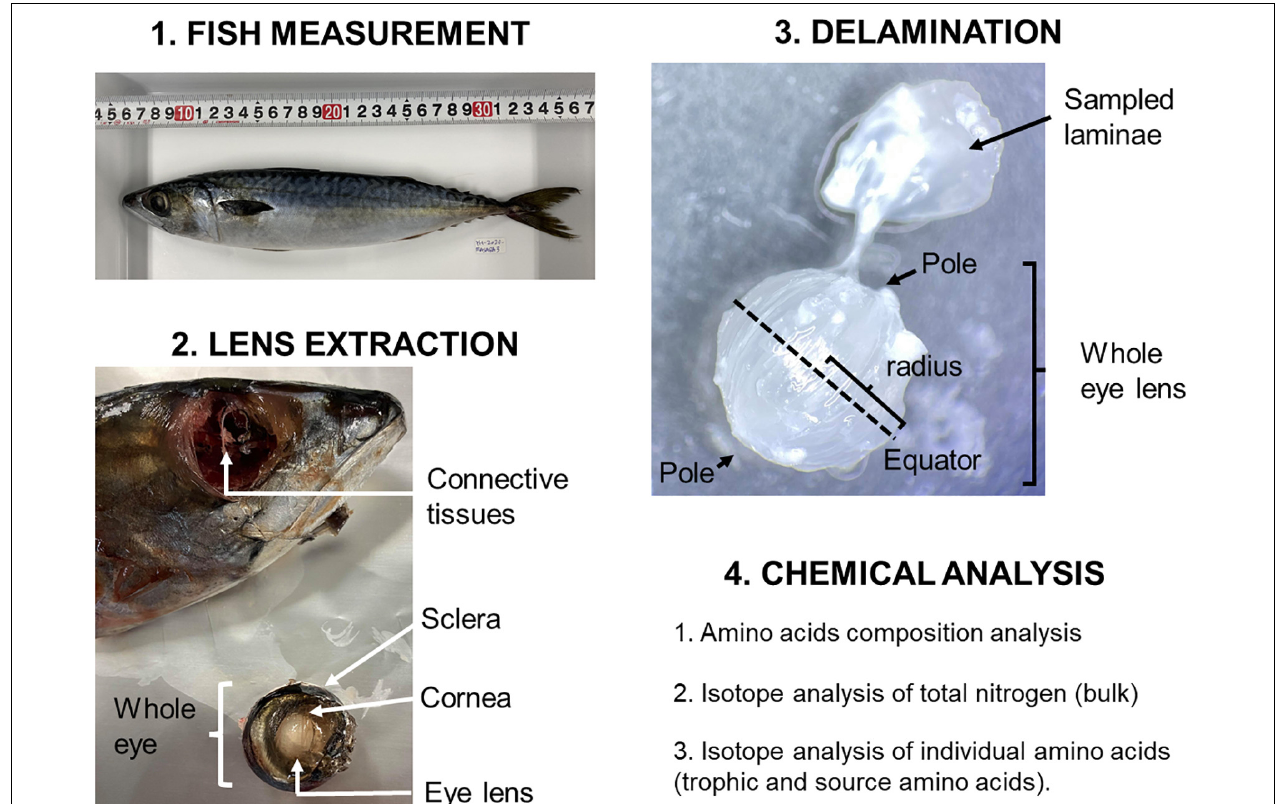
FIGURE 1 | Illustration of workflow for fish eye lens sampling and preparation for isotope analysis (details in the main text).